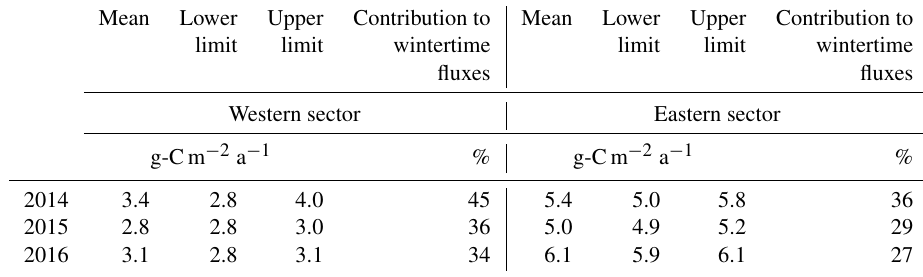
Table 7. Average CH 4 annual emission based on all models with the upper and lower limit and contribution from the winter fluxes. Mean Lower